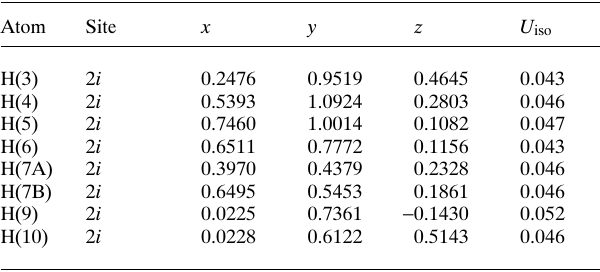
Table 2. Atomic coordinates and displacement parameters (in Å 2 )